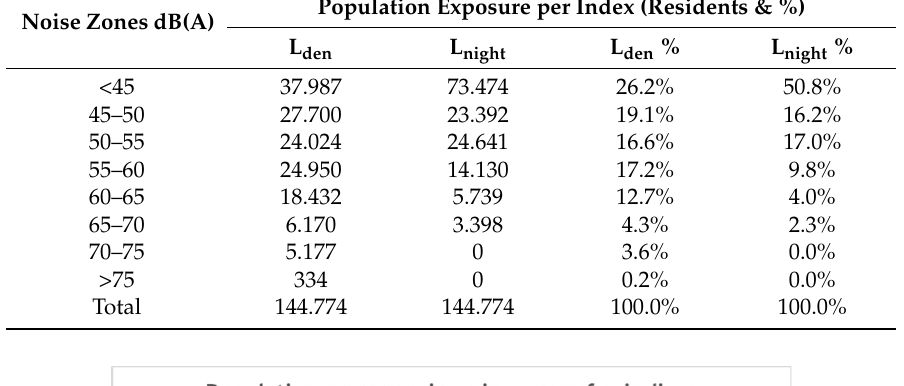
Table 1. Strategic Noise Map of Heraklion—Population exposure in noise zones of airport noise.